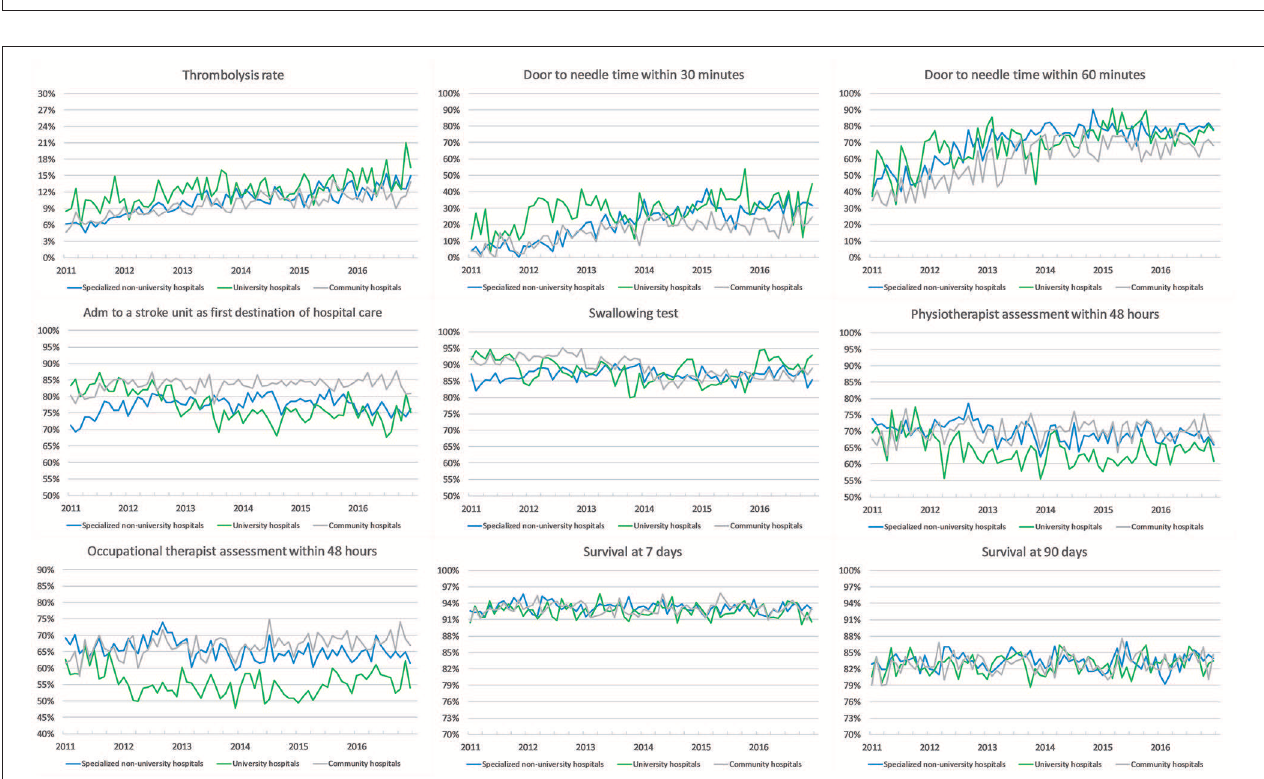
FIGURE 6 | Unadjusted monthly longitudinal analyses stratified by hospital type.